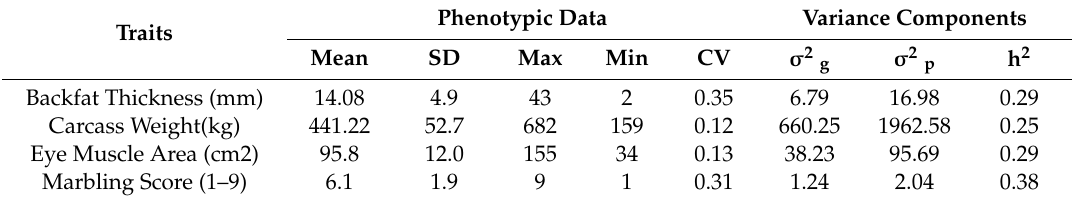
Table 1. Descriptive summary of phenotype data and results of variance component estimation. Traits